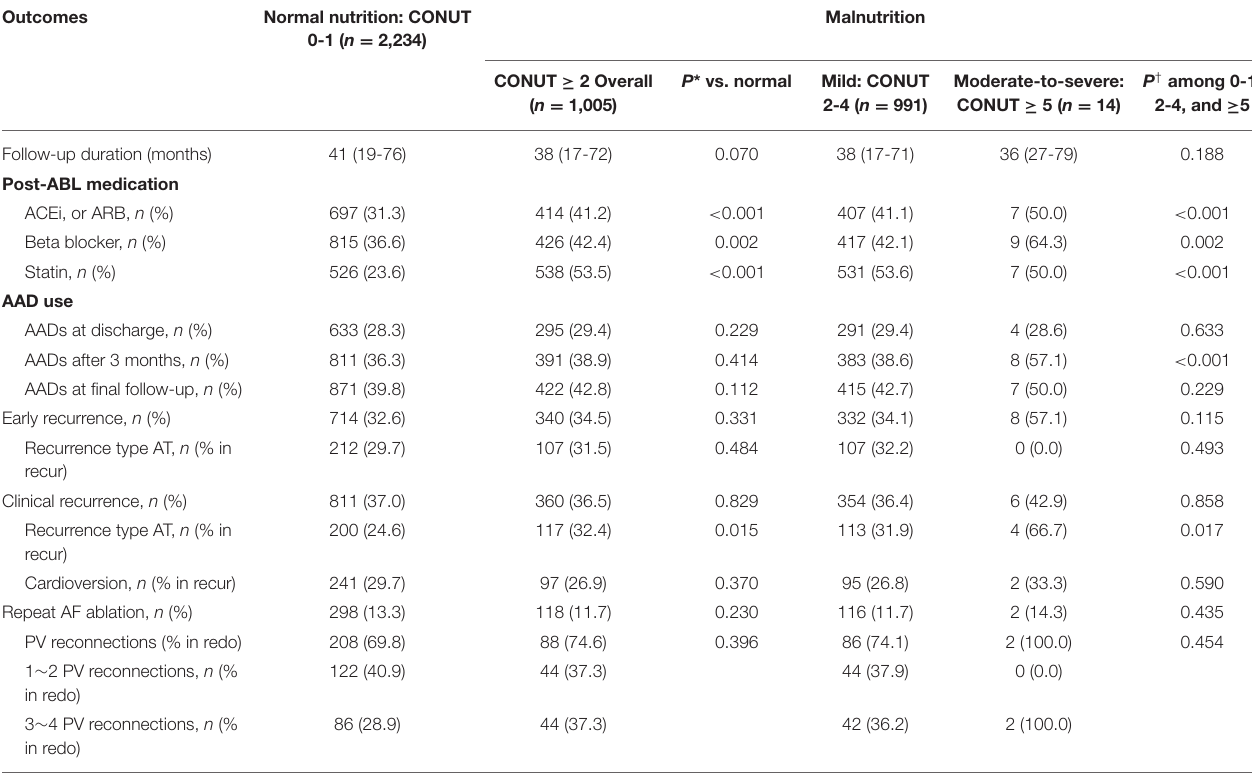
TABLE 5 | Clinical rhythm outcomes. Outcomes Normal nutrition: CONUT